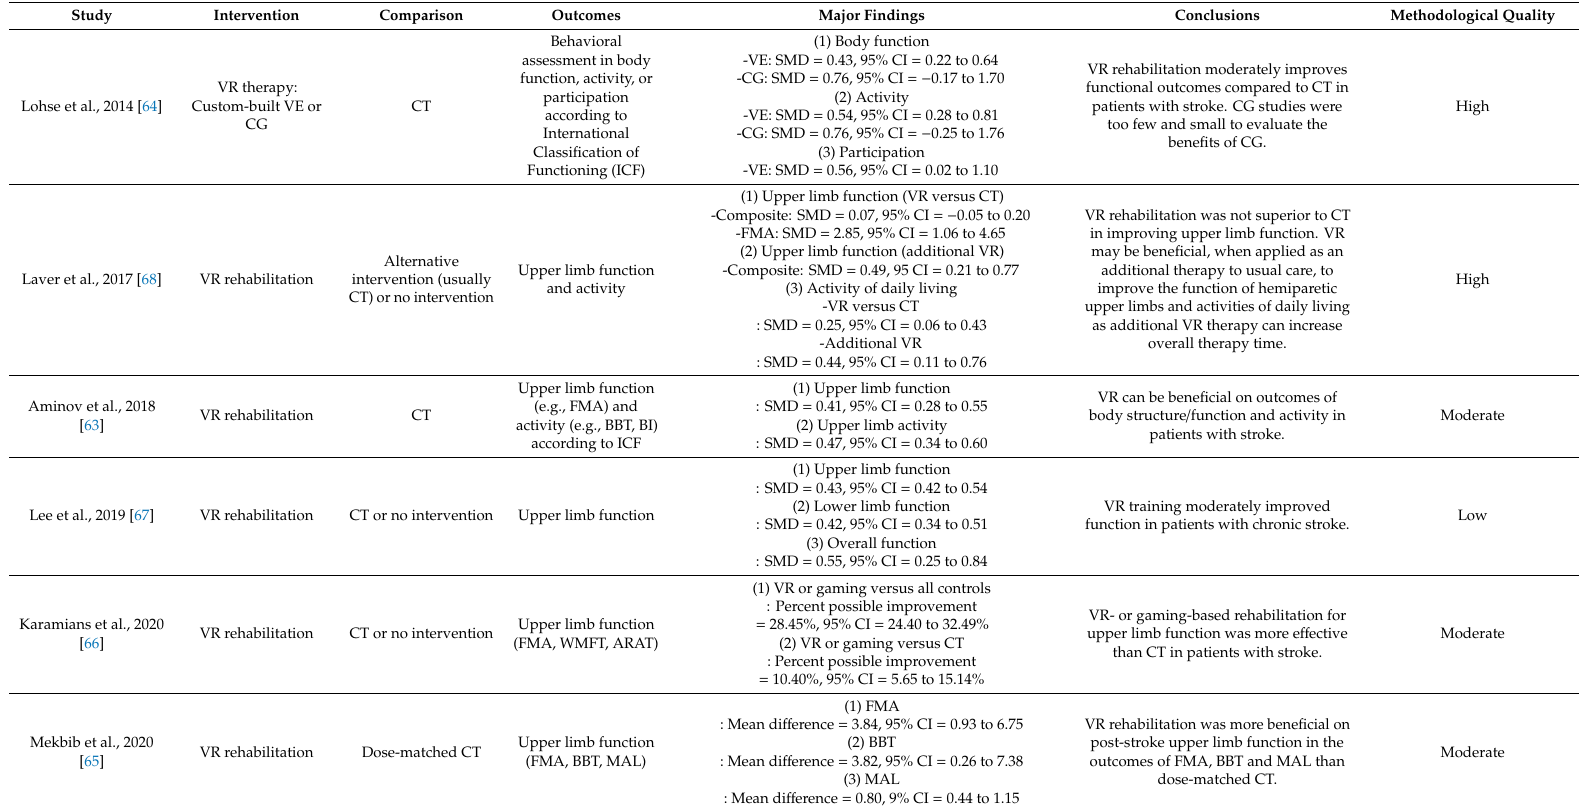
Table 4. Review of findings of included